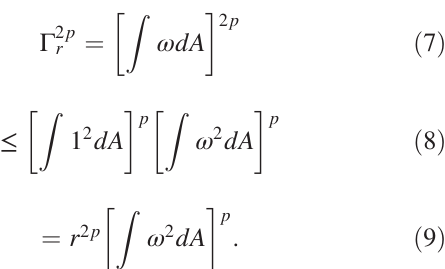
FIG. 13. The function ψ ð r Þ [left-hand side of inequality (13)] as a function of normalized spatial separation r= η for different Reynolds numbers. The curves are seen to collapse, for r ≪ L ( L is the integral scale), at the different Reynolds numbers shown, reasonably well. The limit ψ ð r → 0 Þ ¼ 1 = 3 is marked by the horizontal dashed line. Dash-dotted line indicates the correspond- ing K41